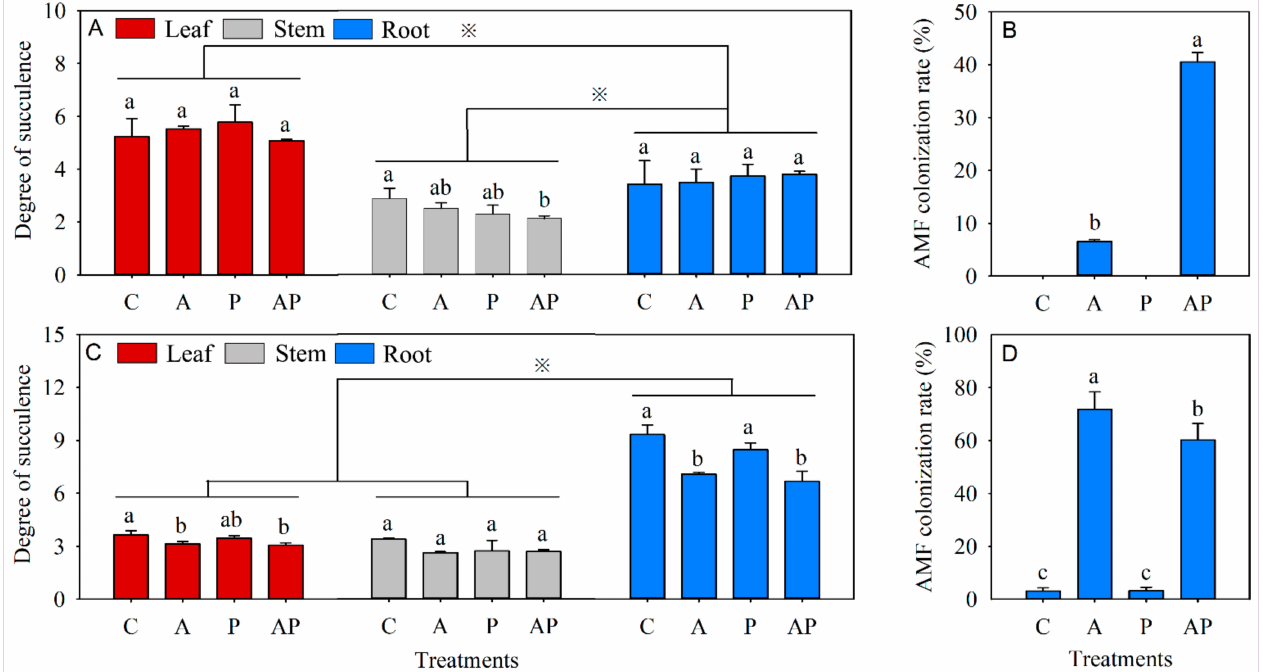
Figure 3. Effects of AMF and PGPR inoculation on the succulence degree ( A , C ) and AMF colonization rates ( B , D ) in Nitraria tangutorum Bobr. (first row) and Elaeagnus angustifolia Linn. (second row). Asterisk indicates significant difference between leaves, stems, and roots at the 0.05 level (Tukey’s test). Each value represents the mean of three replicates. Each bar represents the standard deviation of three replicates. Values are significantly different at the 0.05 level (Tukey’s test) if followed by different letters above the bars. C: control, A: AMF inoculation treatment, P: PGPR inoculation treatment, AP: co-inoculation